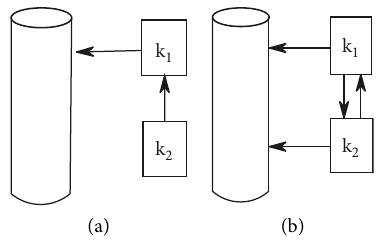
Figure 1: The sketch of the dual media. (a) Dual-porosity media; (b) dual